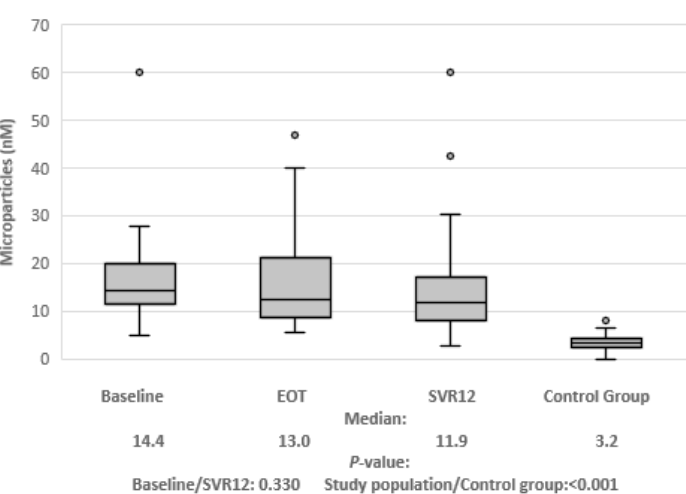
Fig. 1. Microparticles levels in study population and control